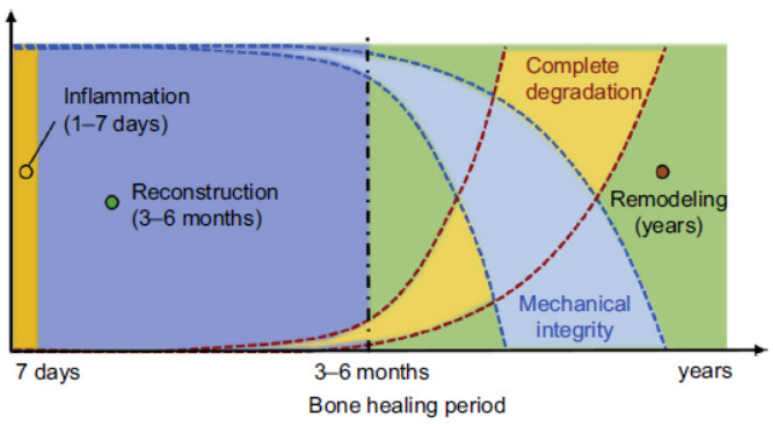
Figure 2. Ideal balance between an implant’s mechanical integrity and corrosion rate [2].